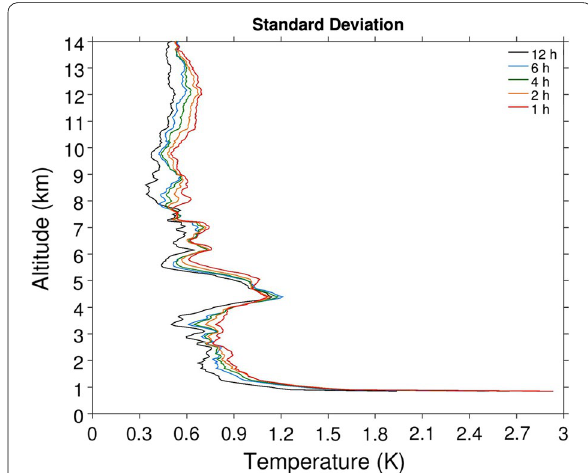
Fig. 13 Profiles of temperature perturbations (standard deviation) for different balloon launch intervals of 1, 2, 4, 6, and 12 h from the intensive radiosonde campaign in December 2005 at the EAR